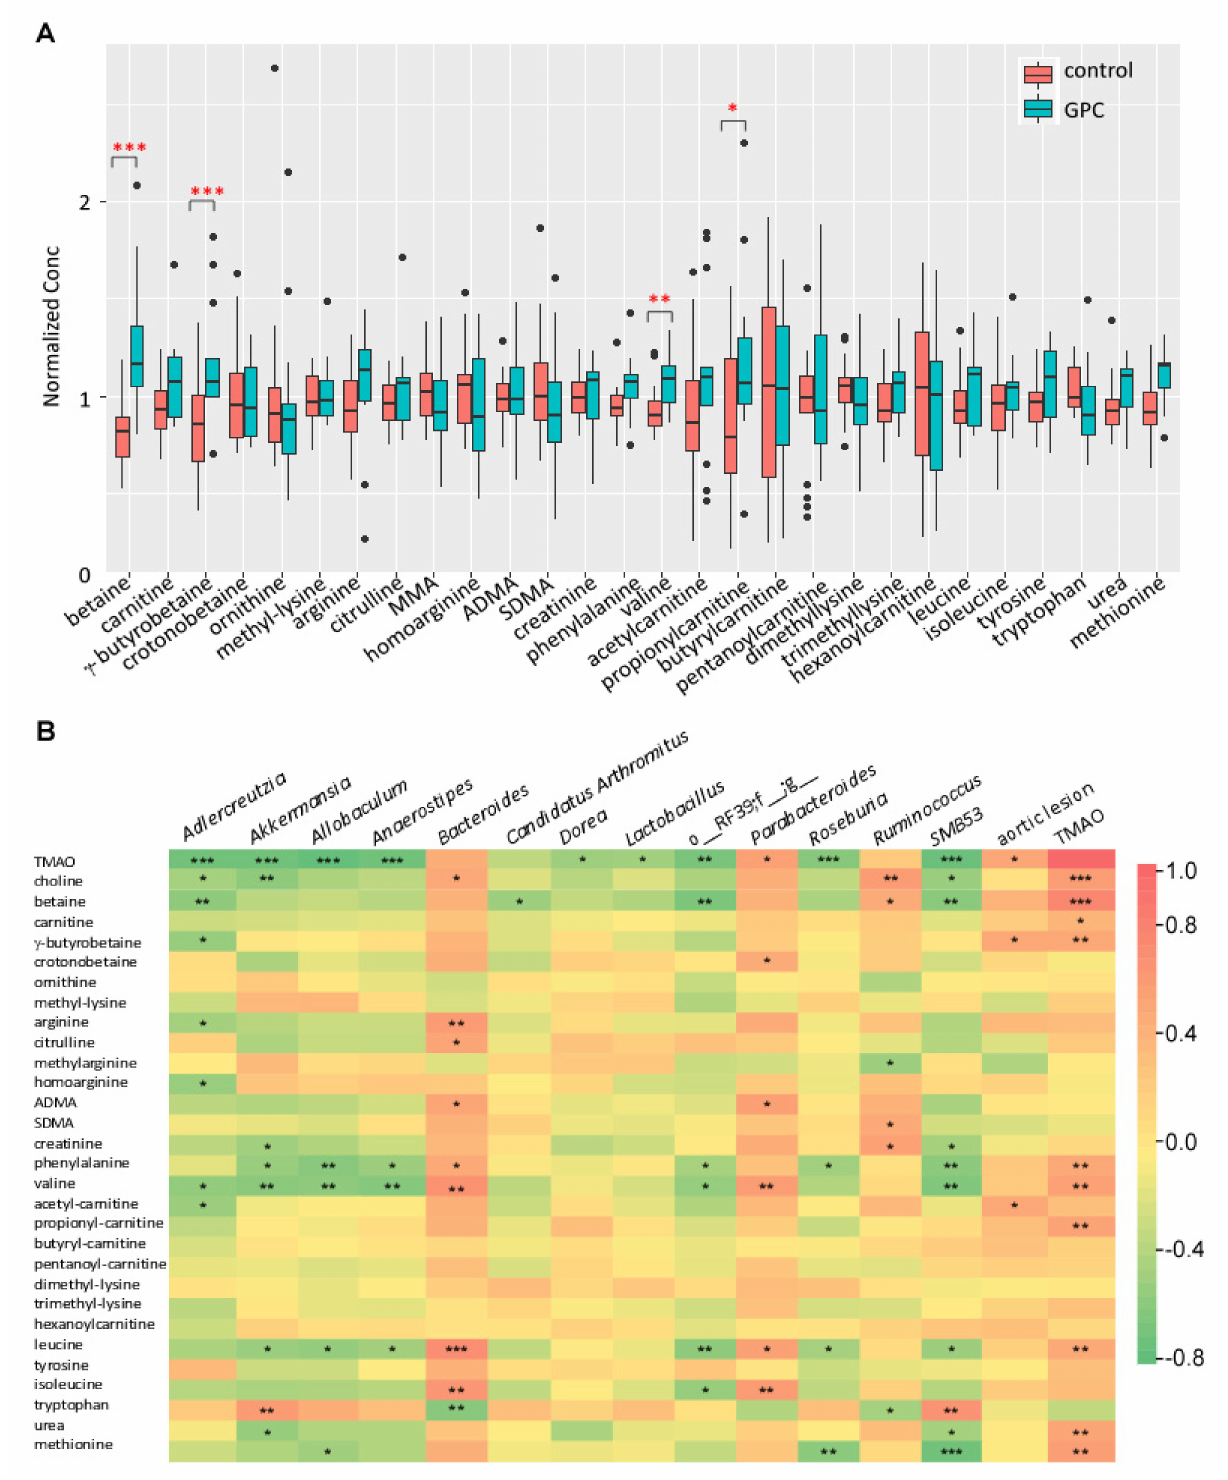
Figure 12. GPC supplementation alters the plasma concentration of gut microbial metabolites implicated in the TMAO pathway. ( A ) Targeted metabolomic profile in plasma in female C57BL/6J Apoe − / − mice fed a GPC supplemented chow diet for 16 weeks versus control chow diet. The concentration for each metabolite was normalized to the average concentration in the combined chow and GPC groups. ( B ) Heat map showing Spearman correlation coefficients for the targeted metabolites and the bacterial taxa showing discrimination between the two diet arms as shown in Figure 8D and aortic lesion area and plasma TMAO level. * p < 0.05; ** p < 0.01; *** p <